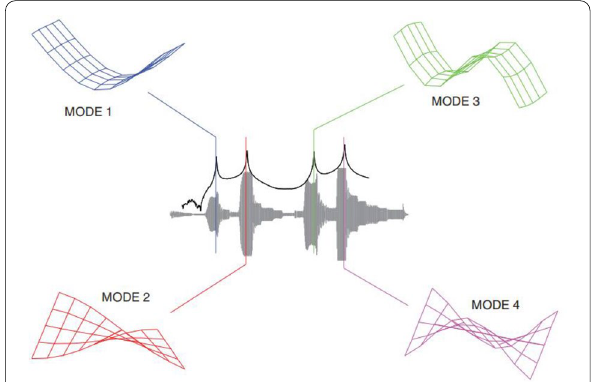
Fig. 7 Mode shape identification using FFT (Aulakh & Bhalla,